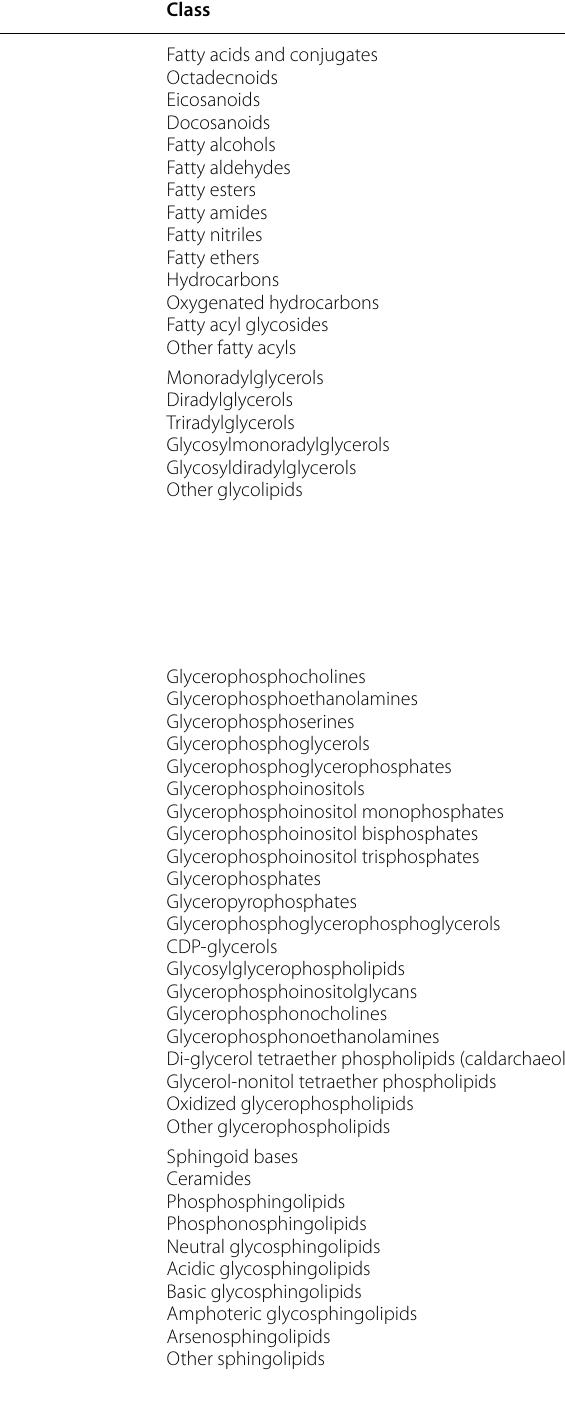
Table 1 Lipid categories, their classes and the structure of representative of each lipid category